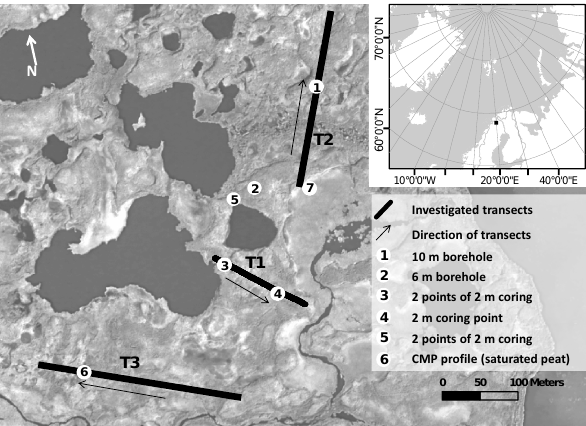
Figure 1. Location of the study site (inset), investigated transects, existing boreholes (Ivanova et al., 2011, points 1 and 2), coring points, and point of CMP measurement (described in Sect. 3.1; aerial photograph from Lantmäteriet, the Swedish land survey,